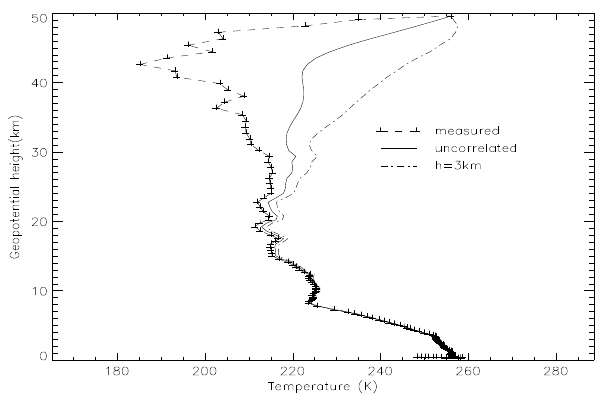
Fig. 10. The sensitivity of the smoothed bending angle profiles to the assumed climatology, using ‘95-07-01-06:22met-gps16’ mea- surement. The vertical axis is ‘impact parameter minus radius of